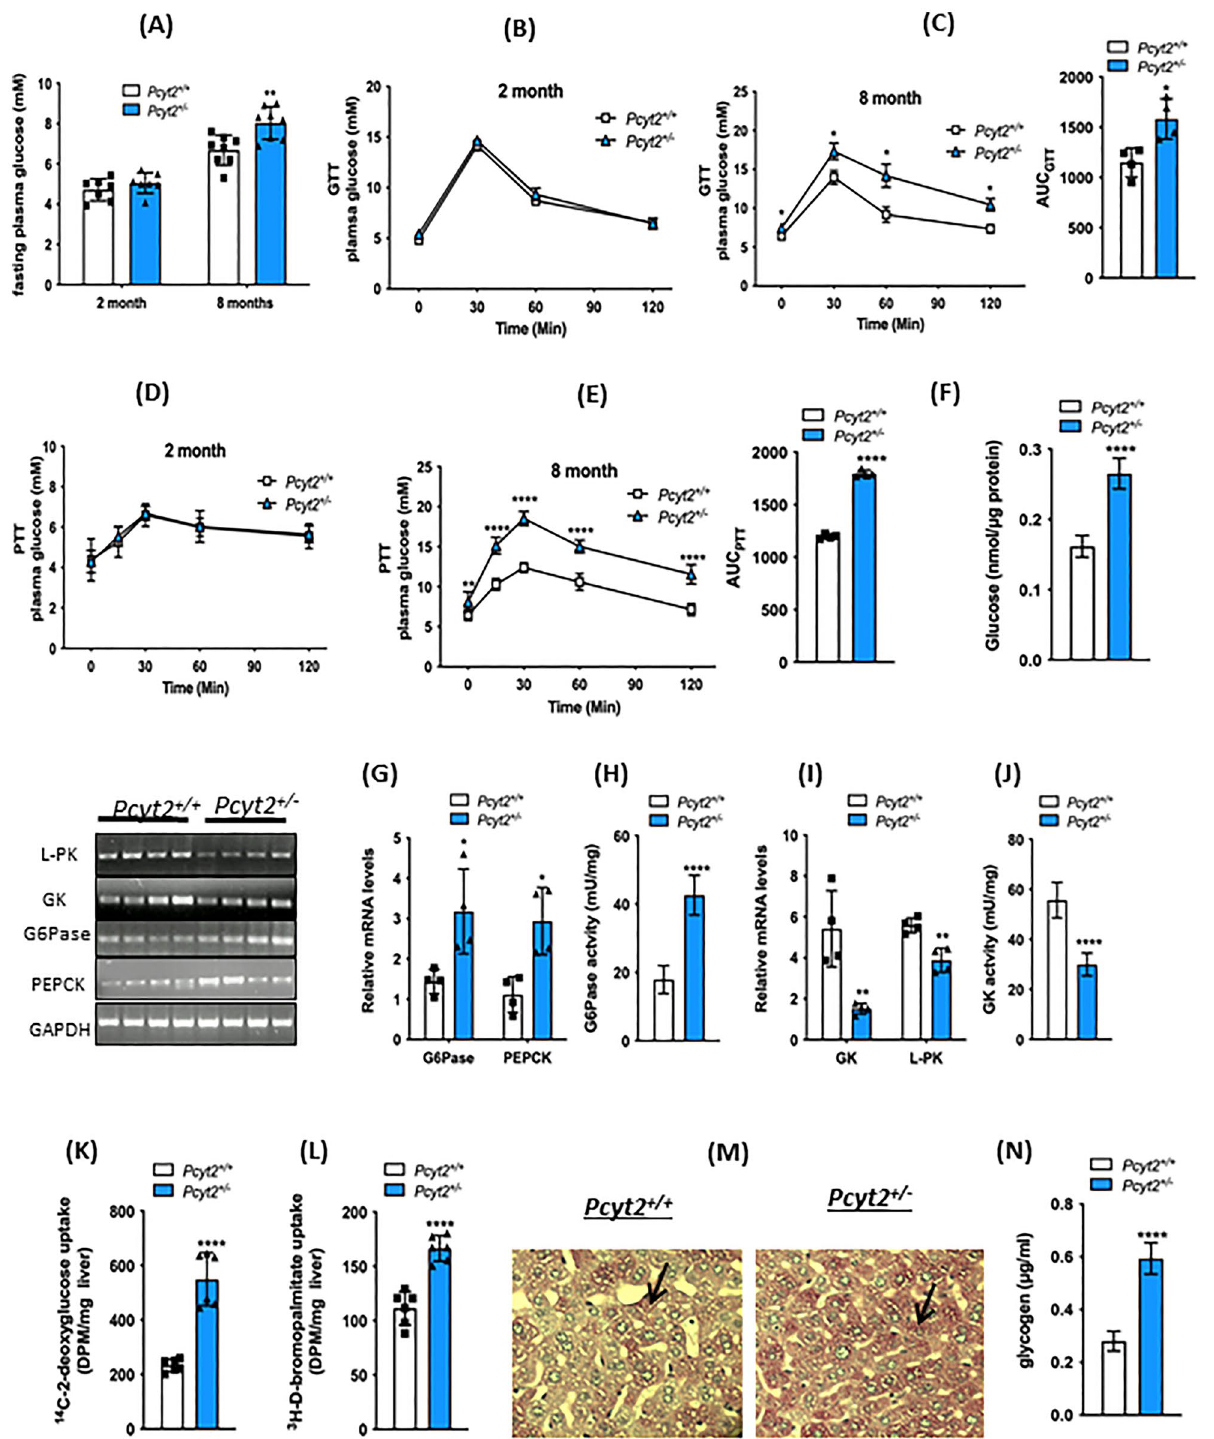
Figure 1. Glucose metabolism is altered in older Pcyt2 + /− mice. ( A ) Fasting glucose levels for 2-mo and 8-mo Pcyt2 + / + and Pcyt2 + /− mice. ( B ) Intraperitoneal glucose tolerance test for 2-mo and ( C ) 8-mo Pcyt2 + / + and Pcyt2 + /− and area under the curve (n = 4). ( D ) Intraperitoneal pyruvate tolerance test for 2-mo and ( E ) 8-mo Pcyt2 + / + and Pcyt2 + /− and area under the curve (n = 4). ( F ) Glucose production in primary hepatocytes (n = 12). ( G ) Relative mRNA expression levels of gluconeogenic enzymes G6Pase and Pepck (n = 4) and ( H ) G6Pase enzymatic activity (n = 12) in 8-mo Pcyt2 + / + and Pcyt2 + /− mice. ( I ) Relative mRNA expression levels of glycolytic enzymes Gk and L-Pk (n = 4) and ( J ) GK enzymatic activity (n = 12) in 8-mo Pcyt2 + / + and Pcyt2 + /− mice. ( K ) [ 14 C]deoxyglucose and ( L ) [ 3 H]bromopalmitate uptake in liver (n = 6). ( M ) Periodic acid-Schiff staining of liver sections for glycogen in 8-mo Pcyt2 + / + and Pcyt2 + /− mice. ( N ) Liver glycogen content of 8-mo Pcyt2 + / + and Pcyt2 + /− mice (n = 12). Band intensities were measured using ImageJ. Data are presented as mean ± SD. * p < 0.05; ** p < 0.01; *** p < 0.001; **** p <